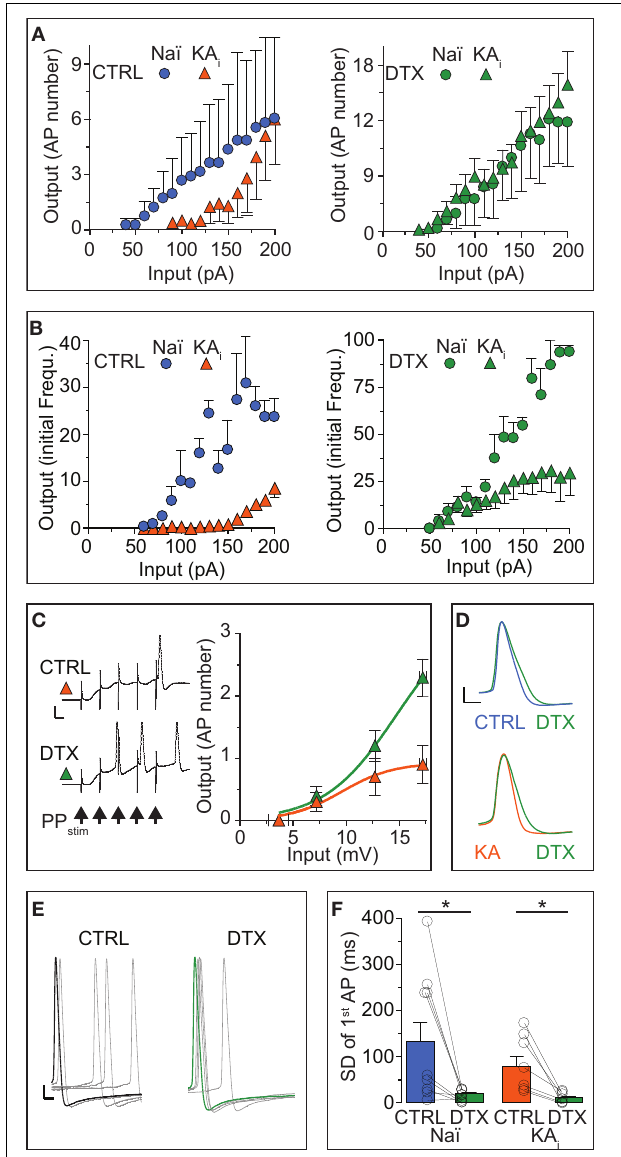
FIGURE 2 | The input/output transfer function of DG cells is controlled by I D . (A,B) Action potential (AP) output evaluated by number (A) and initial frequency (B) was evoked by somatic DC input in DG cells from naïve mice ( Naï, circles ) and KA-injected mice ( KA, triangles ) under control (CTRL) conditions and after DTX application ( green symbols ). The input/output (I/O) curve was shifted to higher input values in KA vs. Naï cells [ (A) , left panel , compare orange triangles with blue circles , respectively]. Application of DTX reduced this difference [ (A,B) , right panels , compare green triangles with green circles, respectively], although with higher input, the AP frequency did not reach naïve levels. (C) To test the effect of increased DTX-sensitive conductance on dendritic signal integration, the above changes in I/O curves were additionally verified with extracellular perforant path stimulation (5 pulses at 100Hz, arrows in left panel ) evoking excitatory postsynaptic synaptic potentials (EPSPs) in KA cells of which the first was measured as input (no such additional verification was performed in naïve cells). Synaptic input triggered no more than one AP at the end